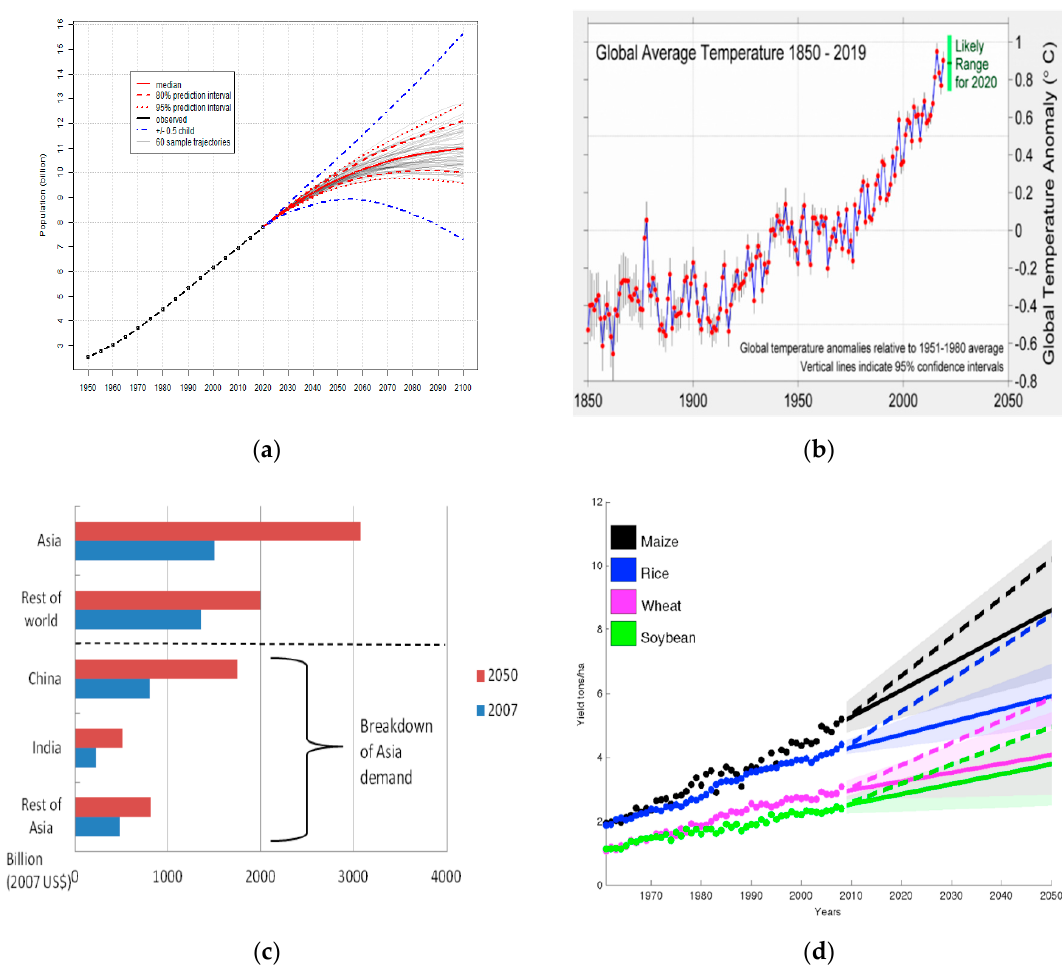
Figure 1. Global trends in ( a ) increase in population (World Population Prospects 2019; http://population.un.org/wpp/), ( b ) average temperature (barkeleyearth.org), ( c ) agrifood demand [4], and ( d )